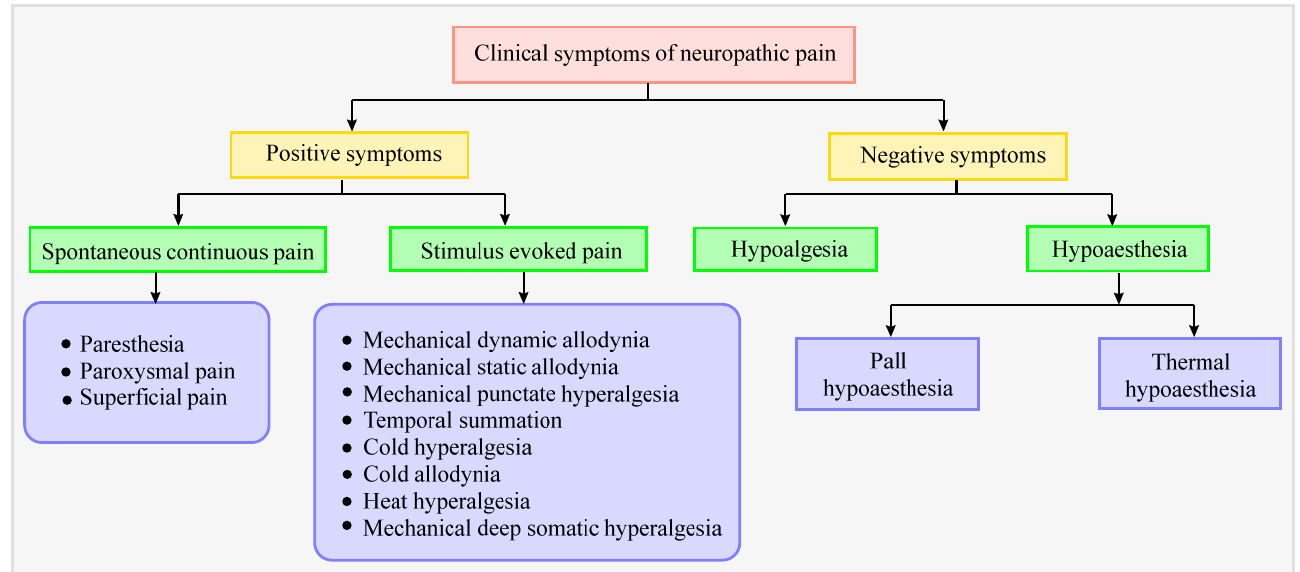
Figure 3. Flowchart depicting positive and negative symptoms of neuropathic pain.